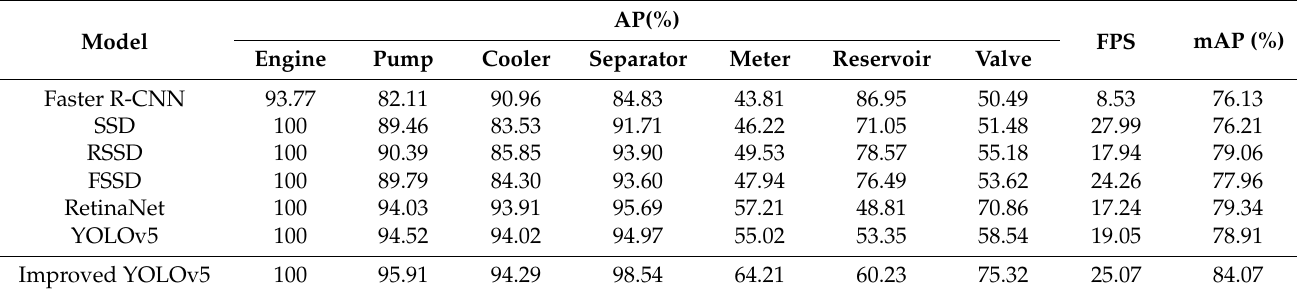
Table 5. Comparison of the detection results on the MEMER test